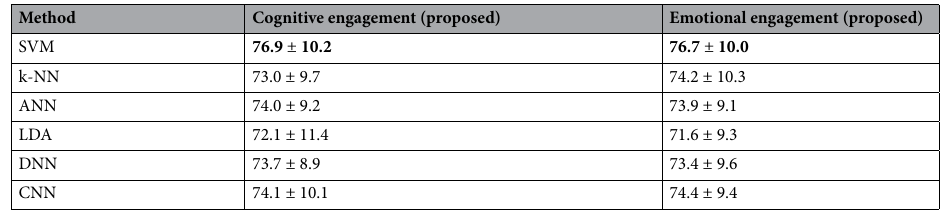
Table 3. Within-subject experimental results. Accuracies are reported on data preprocessed using Filter Bank and CSP for cognitive engagement and emotional engagement classifications. The best performance average values are highlighted in bold.